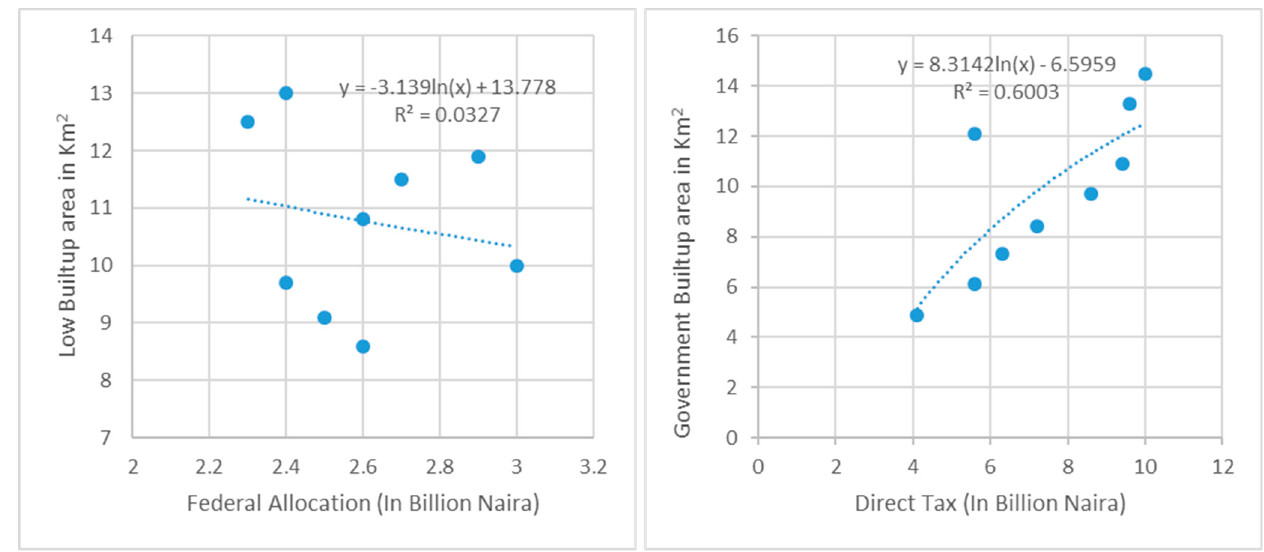
Figure 3. Relationship between socioeconomic variables and medium-density built-up areas in Uyo from 2010 to 2018.